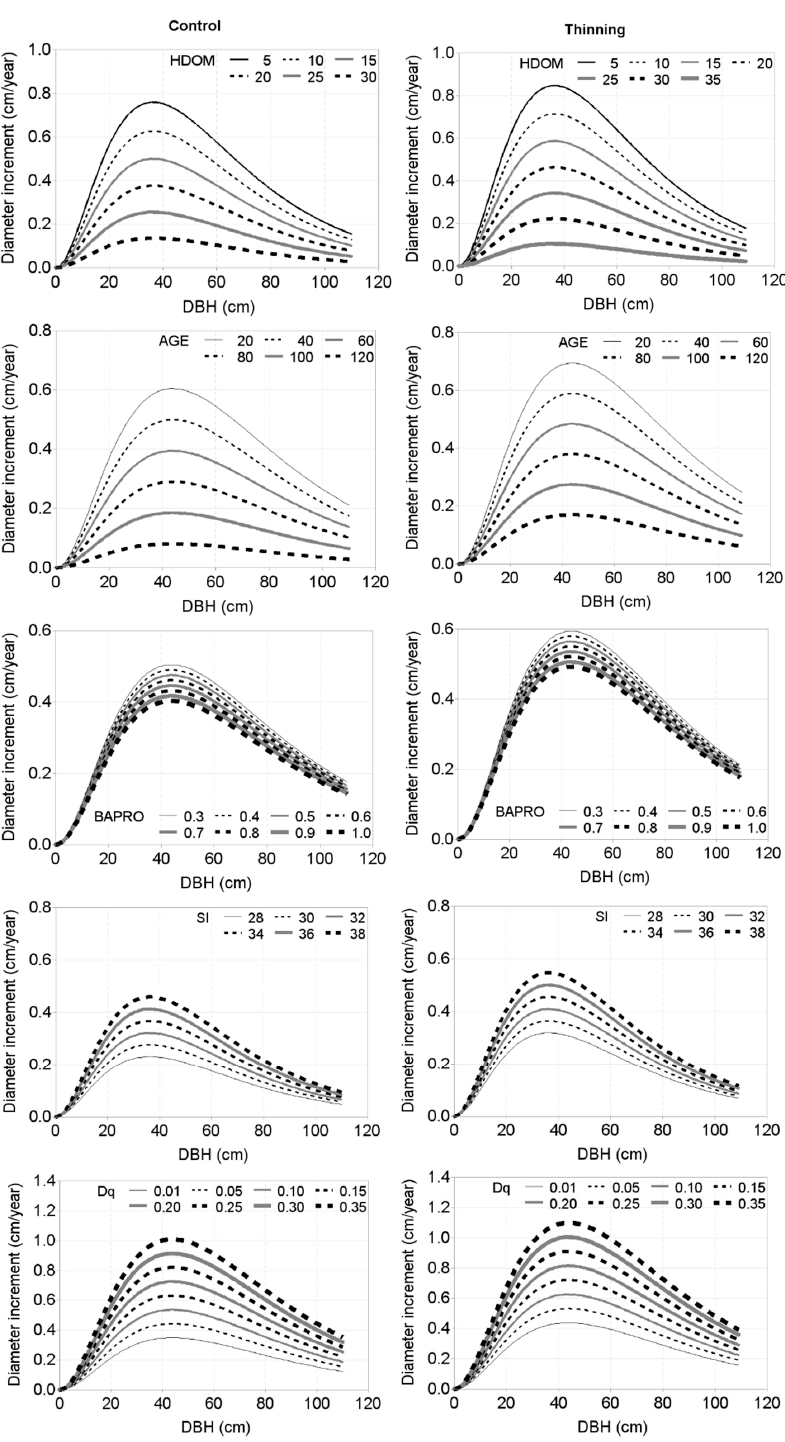
Figure 5. Effects of dominant height (HDOM), stand age (AGE), basal area proportion of a species of interest (BAPRO), site index (SI), ratio of DBH to quadratic mean diameter (Dq) on the diameter increment, DBH: diameter at breast height. Curves were produced using the parameter estimates in Table 5 (only fixed parts of the mixed-effects model). Mean values of the data were used for predictors except variable of interest in the figure, which was allowed varying from approximately minimum to maximum in the measured data.